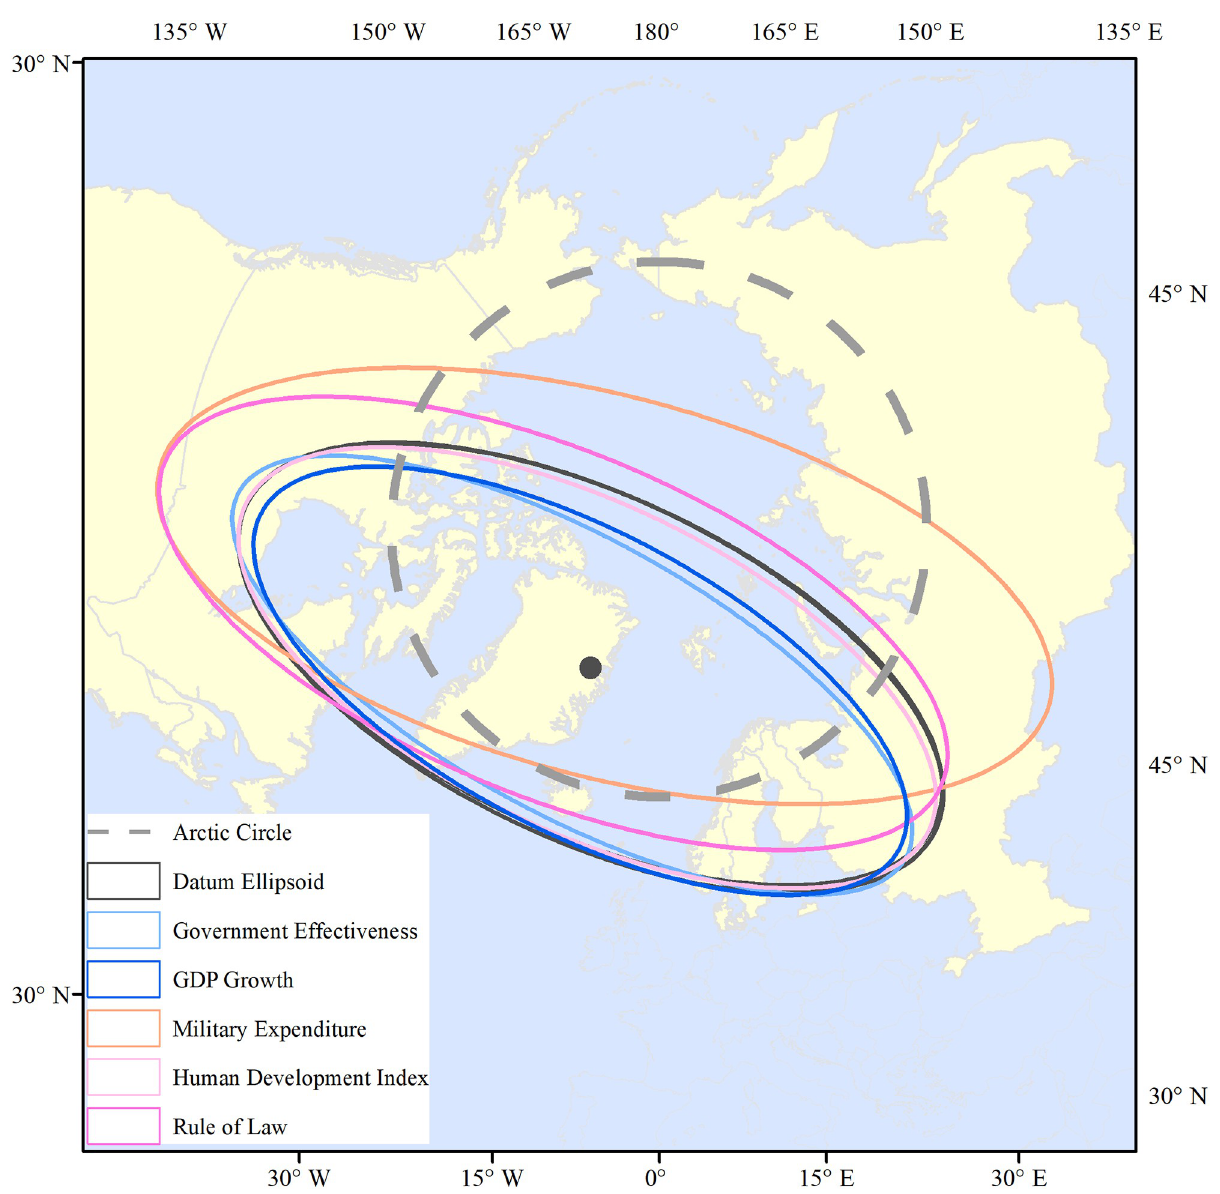
Fig 7. SDE of related geopolitical environmental indicators in the Arctic Passage. The boundary was obtained from Natural Earth (http://www. naturalearthdata.com/).